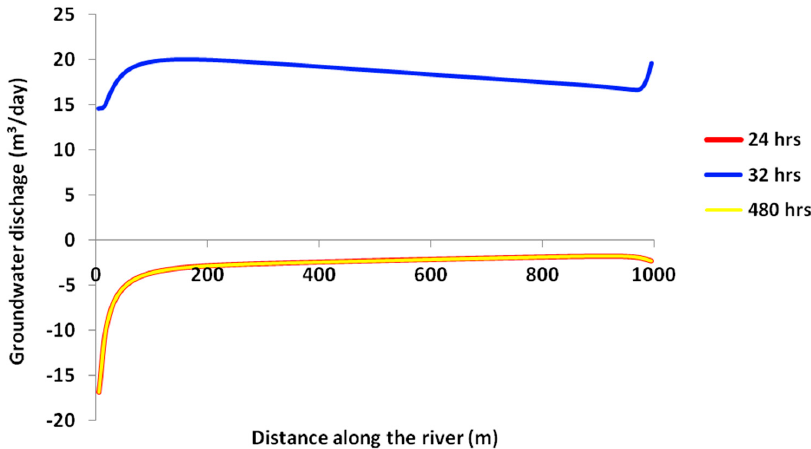
Figure 14. Groundwater discharge at a lateral distance of 10 m of the river-aquifer boundary obtained from STRIVE along the Aa River based on the hydrodynamic river boundary with a transient simulation at times of 24, 32, and 480 h.